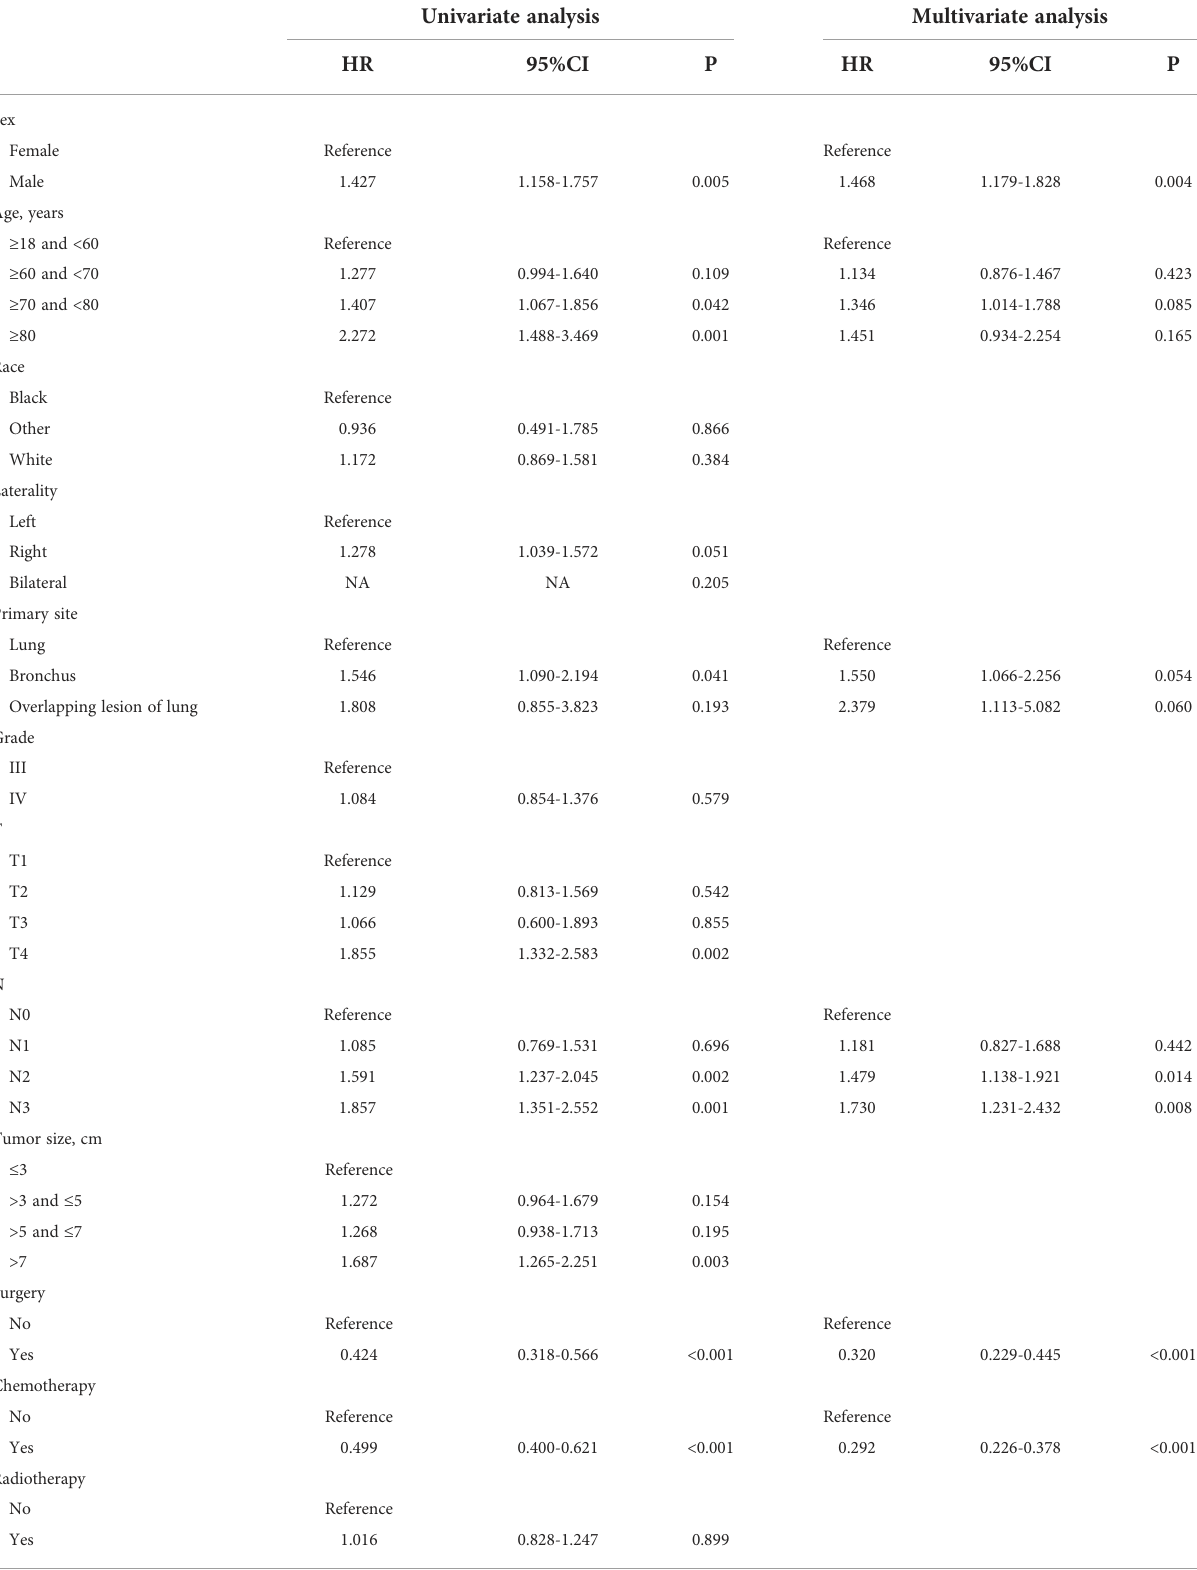
TABLE 4 Analyses of overall survival in LCNEC patients with distant metastasis using univariate and multivariate Cox